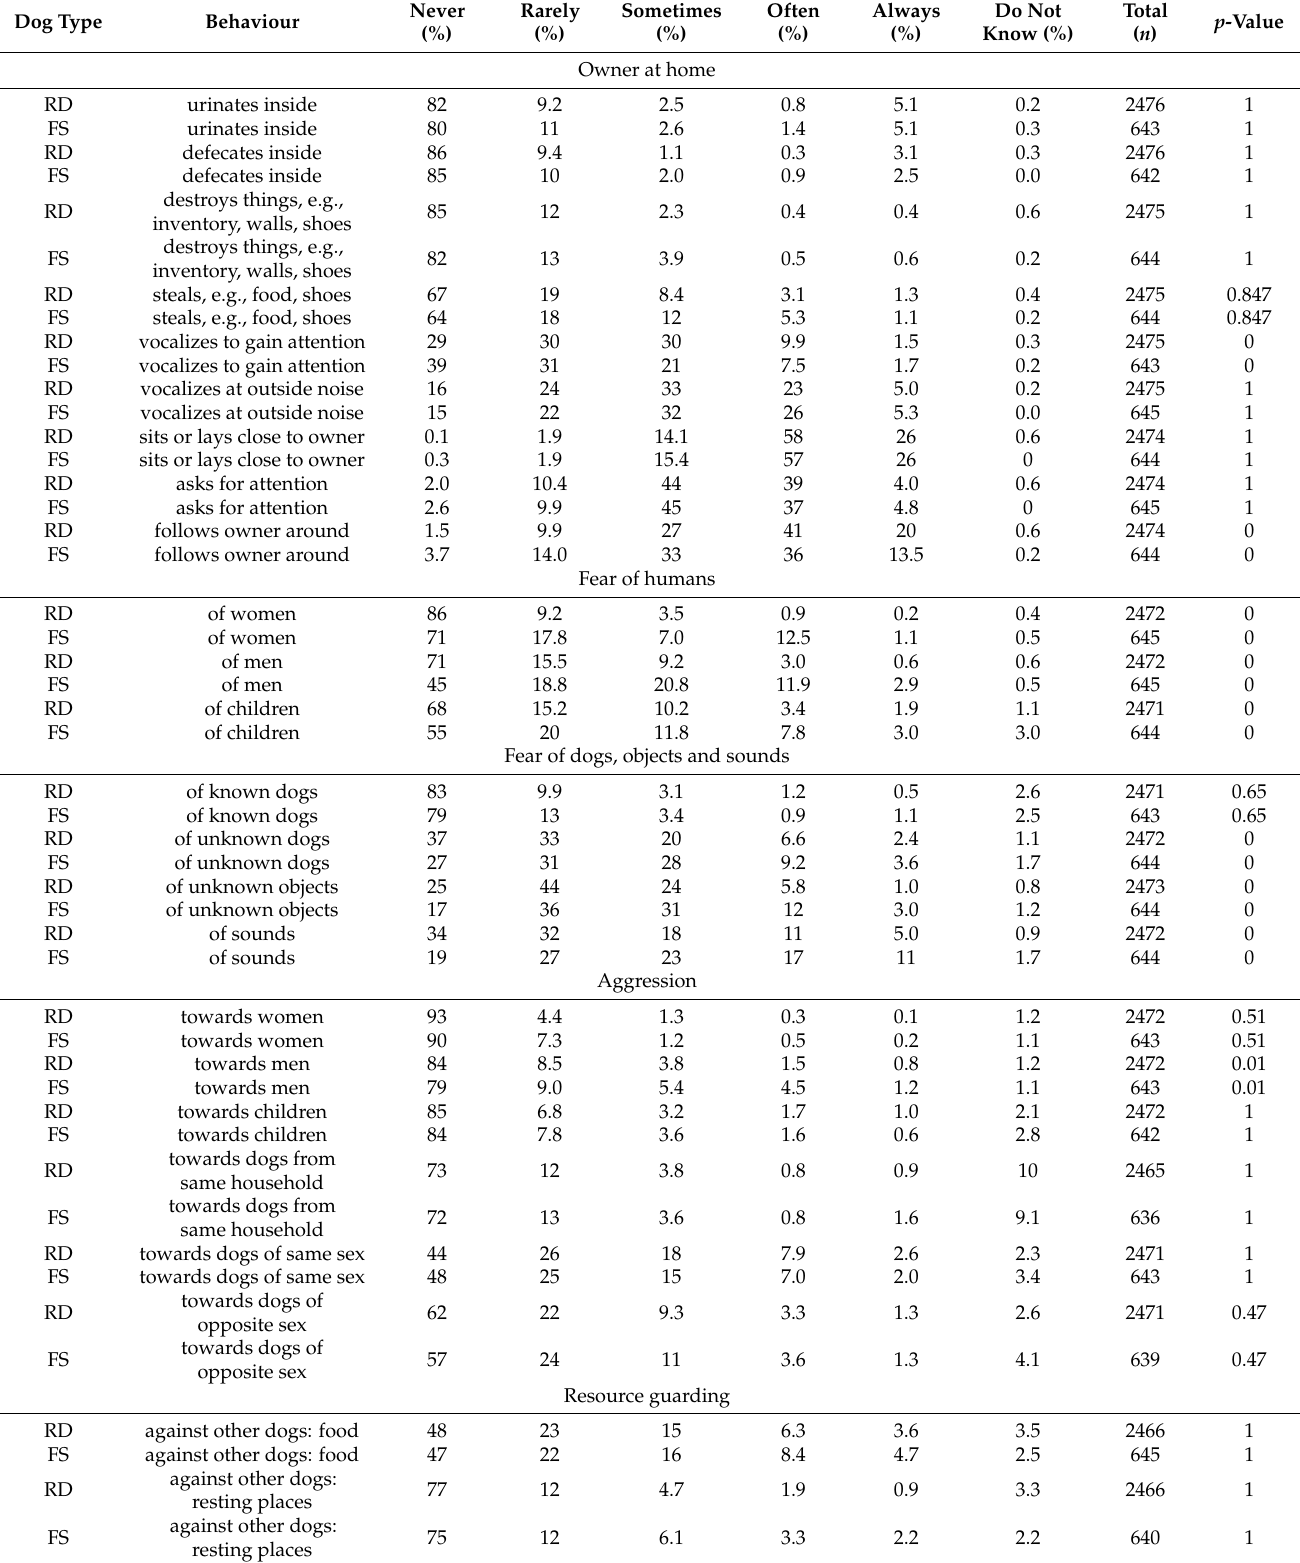
Table A1. An overview of all 45 behavioural questions, including the distribution of answers for owners of former street (FS) dogs and dogs reared in Denmark (RD) between the six answer options and p